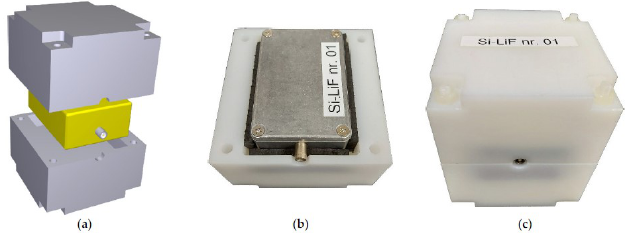
Fig. 3. (a) 3D sketch of the SiLiF detector; (b) a SiLiF hosted in a half moderator; (c) final assembling of a SiLiF.